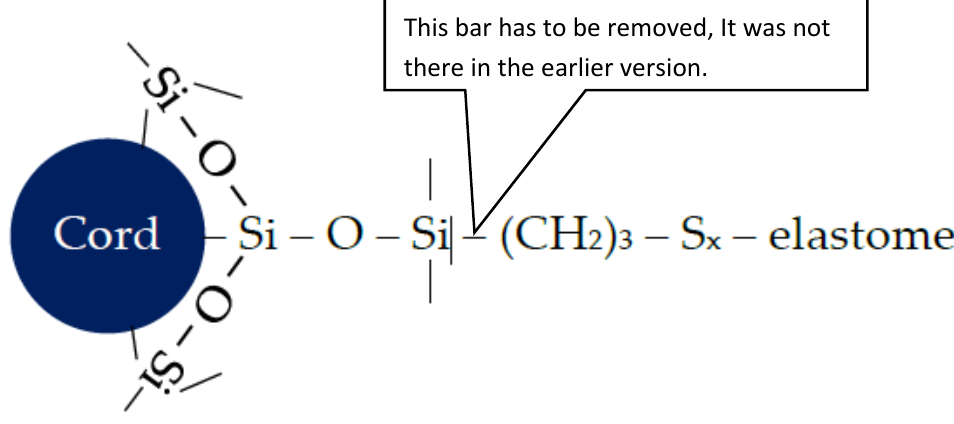
Figure 4. Bond between the cord and elastomer.